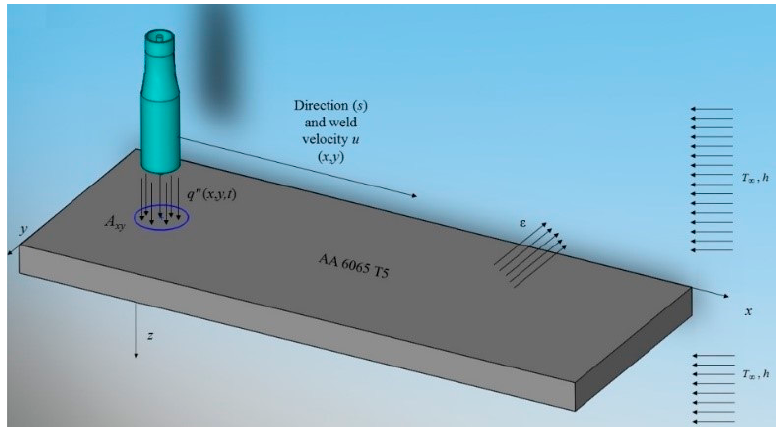
Figure 1. Scheme representation of the three-dimensional thermal welding process.